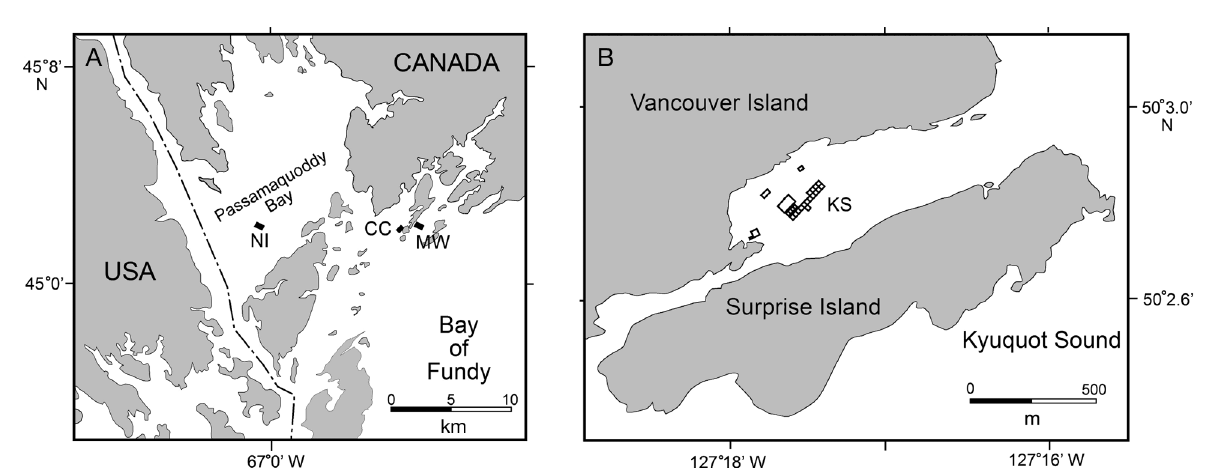
Fig. 1. Location of study sites in (A) the Bay of Fundy, New Brunswick (Atlantic salmon farms), and (B) near Vancouver Island in British Columbia (sablefish farm). The Navy Island (NI), Charlie Cove (CC), Man-O-War (MW) and Kyuquot Sound (KS) fish farms are indicated by the